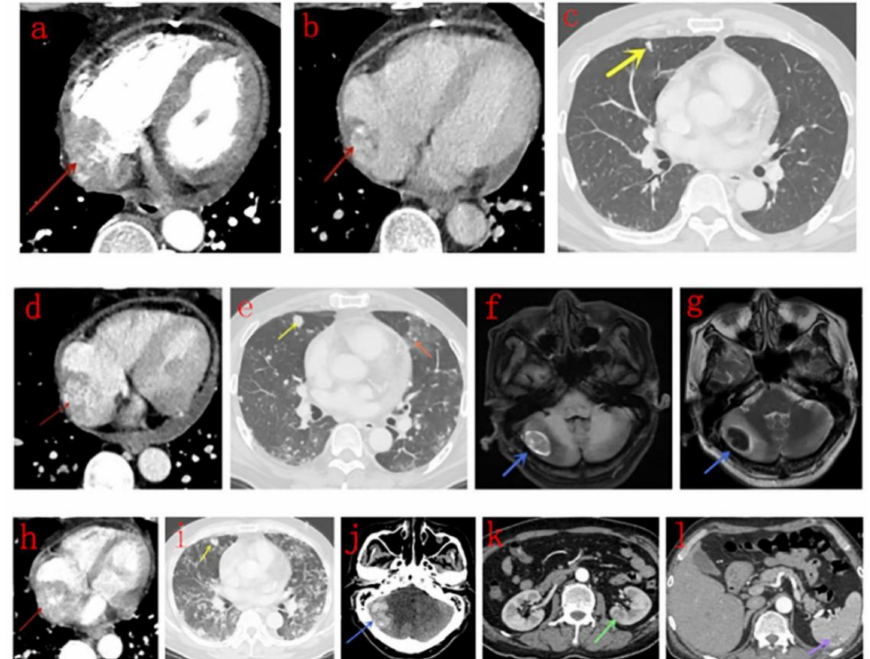
Figure 1. Male, 52 years old, right atrium angiosarcoma. ( a – c ): Contrast-enhanced computed tomography (CT) scans in the arterial ( a ) and venous ( b ) phase indicates a mass with heterogeneous centripetal enhancement (red arrow), and multiple solid nodules ( c ) are noticed in the lungs (yellow arrow). ( d – g ): 1.5 months later, pericardial e ff usion appears ( d ), metastases (yellow arrow) in the lungs are more extensive, halo sign appears (e, orange arrow). Metastasis in the right side of the cerebellum (blue arrow) presents as inhomogeneous hyperintensity on T1WI ( f ) and hypo-intensity on T2WI ( g ) with surrounding edema. ( h – l ): Another month later, the mass (red arrow) becomes larger, and the adjacent pericardium invasion is more extensive ( h ), and metastases in the lungs are much more extensive ( i ). The metastasis in the right side of the cerebellum (blue arrow) is larger ( j ). Metastases in the kidney ( k , green arrow) and spleen ( l , purple arrow)